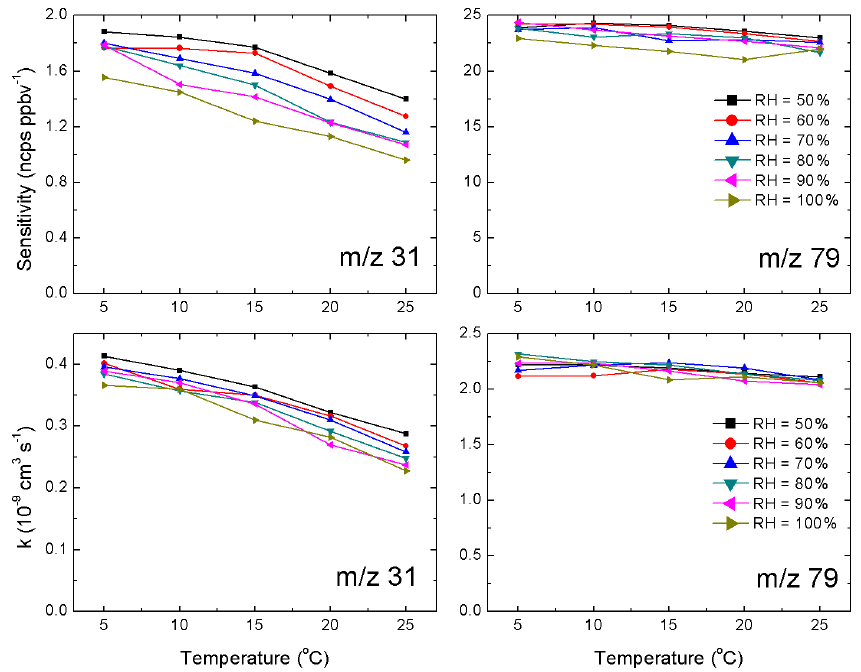
Figure 3. The effect of ambient temperature on sensitivity and experimental k value of HCHO ( m/z 31) and benzene ( m/z 79) under different RH.